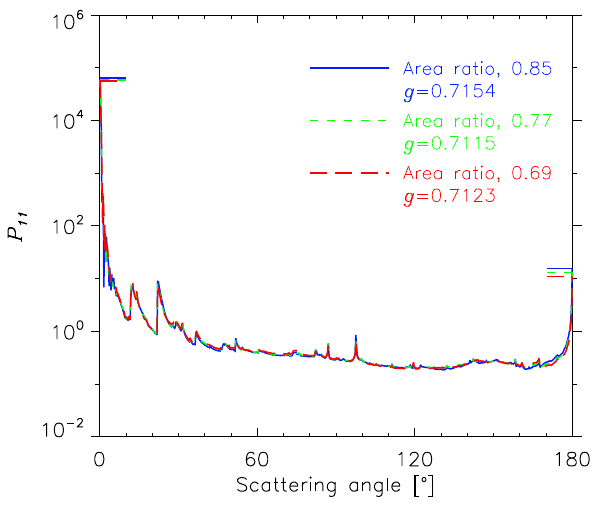
Fig. 11. P 11 and g for the 3Bs with varying area ratio. The direct forward and backward peaks are indicated by bars. The shape of each 3B is shown in Fig. 8.